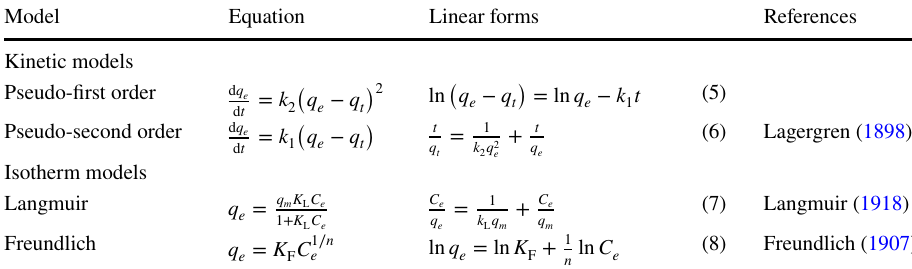
Table 1 Used models for the kinetic and isotherm studies